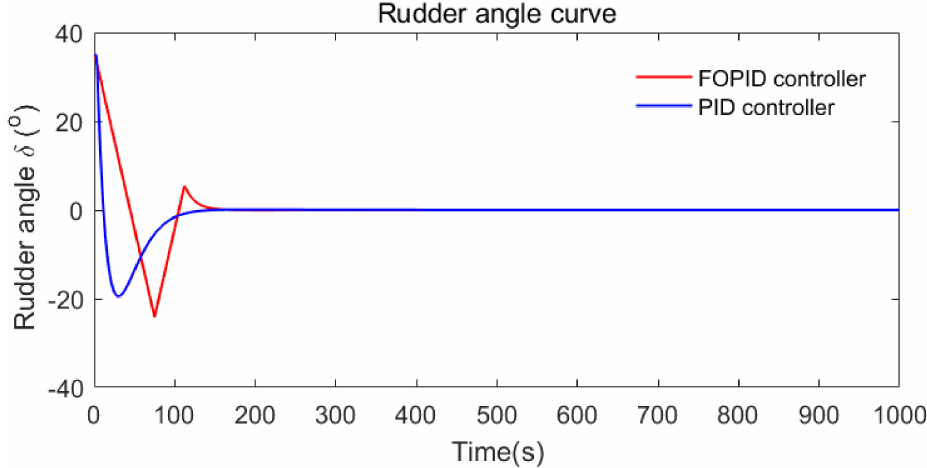
Figure 10. Rudder angle curve with FO PI λ D µ controller and the PID controller.